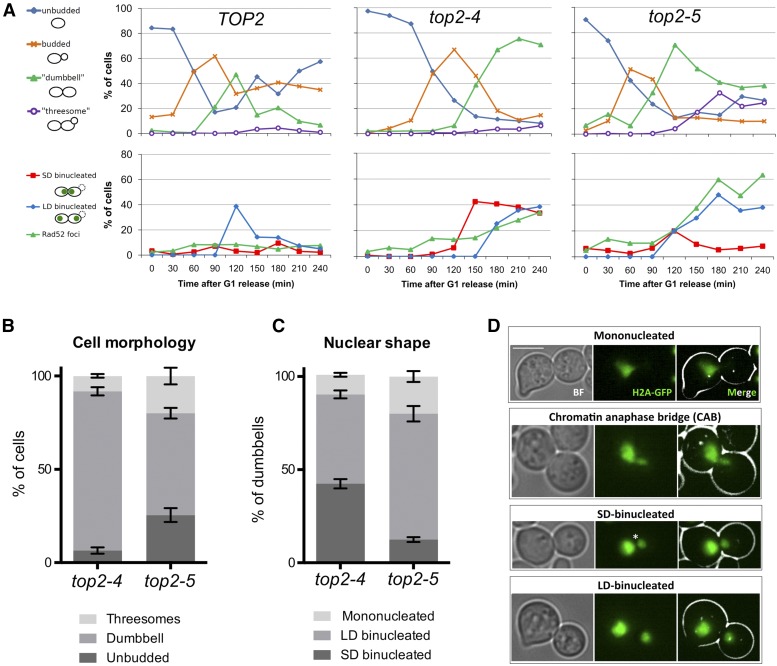
Cell morphology and segregation of the nucleus upon inactivation of Top2 by the temperature-sensitive top2-4 and top2-5 alleles. (A) HTA2-GFP Rad52-RedStar2 yeast cells carrying different alleles of the TOP2 gene (wild-type TOP2 and thermosensitive alleles top2-4 and top2-5) were synchronized in G1 at the permissive temperature (25°) and then released into a synchronous cell cycle at 37° for 4 hr. Samples were taken every 30 min and directly analyzed by fluorescence microscopy. More than 150 cells were counted for each time point. Upper charts depict the budding pattern of the population. Lower charts depict the percentage of cells with histone-labeled split nuclear masses that either remained at a short distance (≤1 µm) from one another (“SD-binucleated”) or were separated by a longer distance (“LD-binucleated”). Percentage of cells with at least one Rad52 focus is also included. (B) Stacked bar chart of the observed end-point budding morphologies from three independent experiments (after 4 hr at 37°, mean ± SEM). (C) Stacked bar chart of the nuclear morphologies observed for the dumbbell subpopulation from (B). (D) Examples of different nuclear morphologies observed in cell dumbbells of top2-ts mutants. The asterisk highlights that SD-binucleated cells have an apparent segregation defect, yet a proper chromatin anaphase bridge (CAB) cannot be visualized. The bar corresponds to 5 μm.